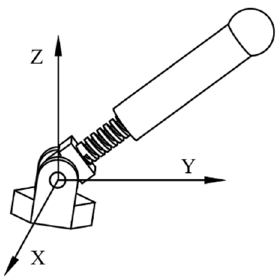
Figure 7. Coordinate system of first branch chain of 3RPS rotary part.